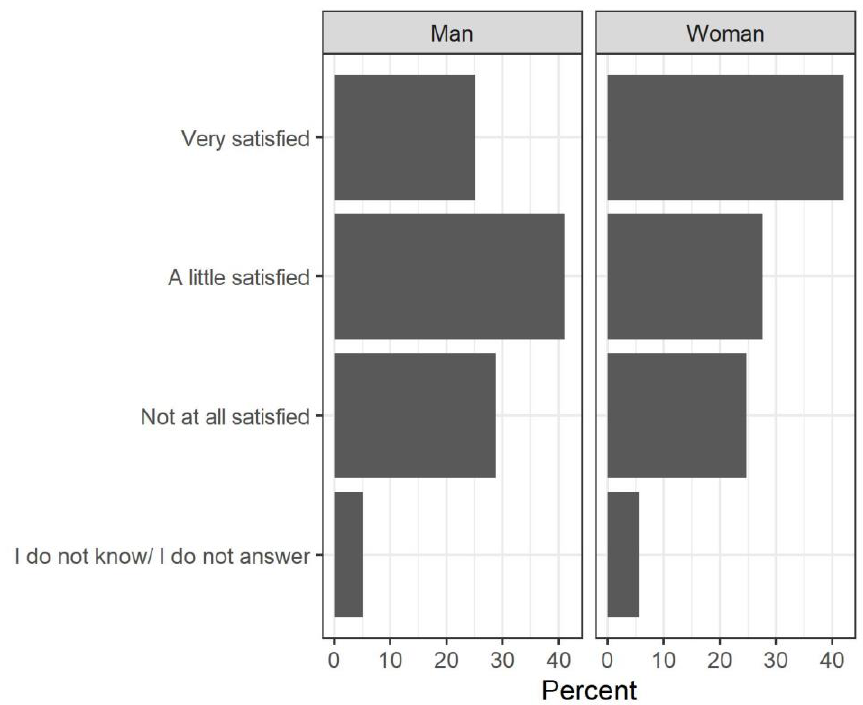
Figure A4. Cross-tabulation of attitudes of believers about the reaction of the Church by gender (% by gender). Χ 2 = 14.9245, df = NA, p = 0.05 (Pearson’s Chi-squared test with simulated p -value based on 2000 replicates).